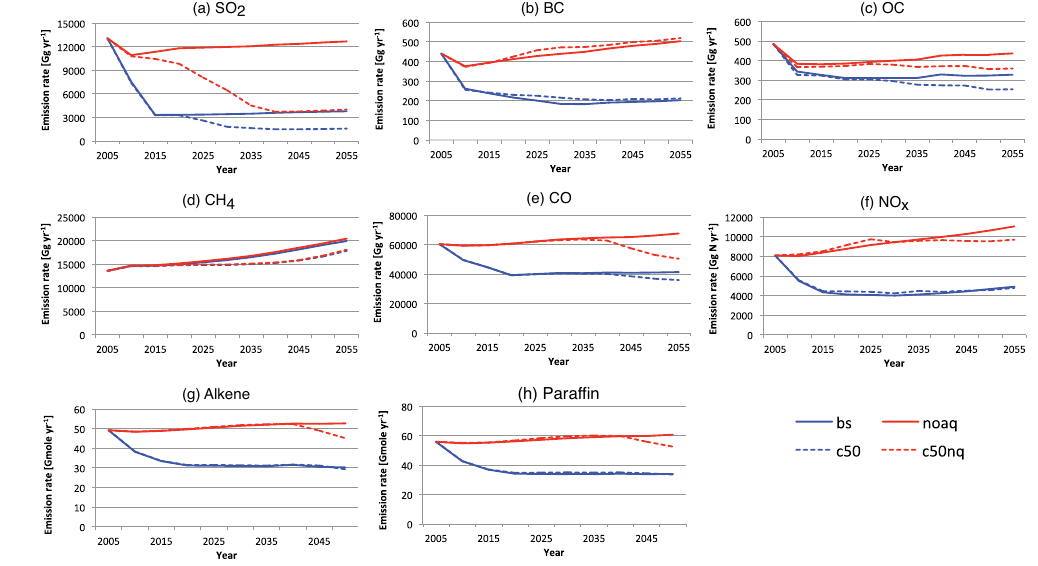
Figure 1. Emission plots of the four GLIMPSE US scenarios. See Sect. 2 for